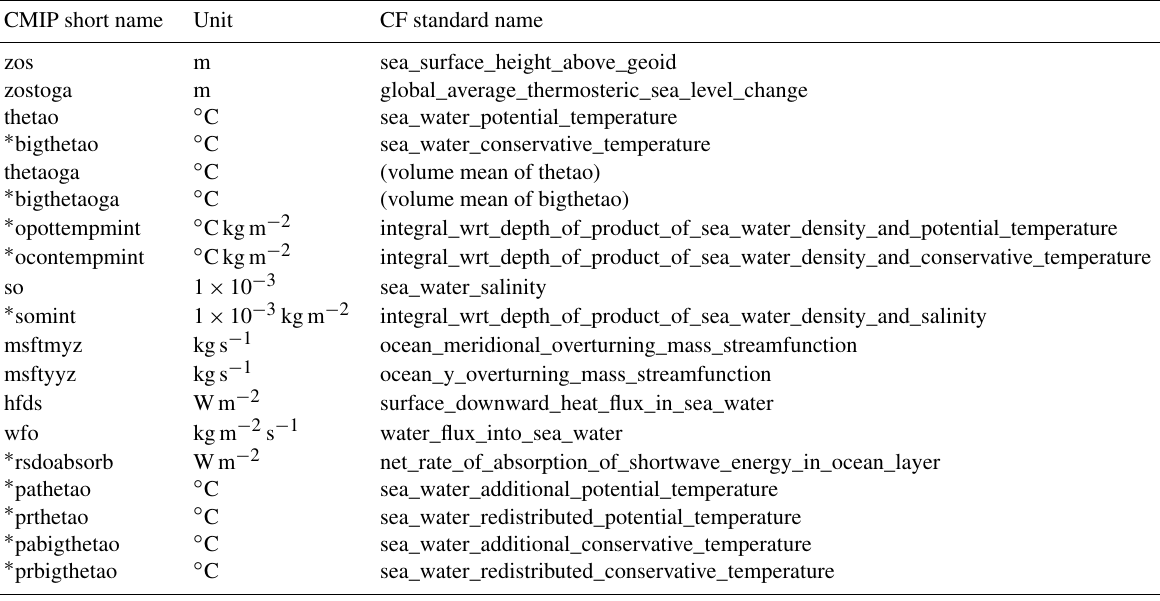
Table 3. Ocean model diagnostics of particular interest to FAFMIP analyses (as well as the process-based diagnostics of Table 4). CMIP short